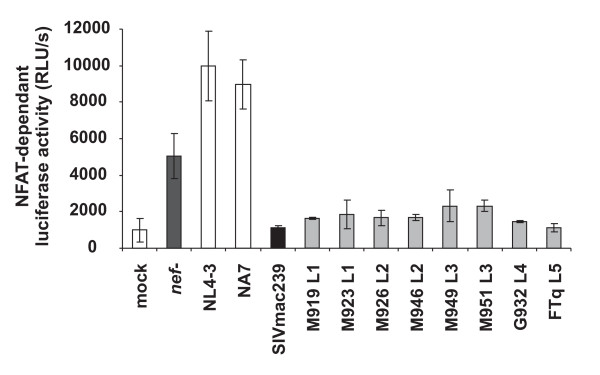
SIVsmm nef alleles inhibit NFAT induction. Analysis of Jurkat cells stably transfected with an NFAT-dependent reporter gene following transduction with the indicated HIV-1 Nef/eGFP constructs and subsequent stimulation with PHA. Levels of NFAT-dependent luciferase reporter activity are the average (± SD) of triple infections. The asterisks denote a statistical significance (P < 0.01) between HIV-1 and SIV Nef activity. Similar results were obtained in two independent experiments.